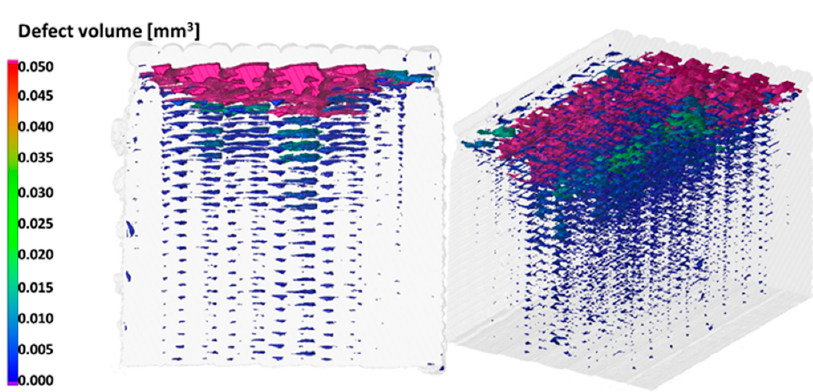
Figure 5. CT picture of a specimen.